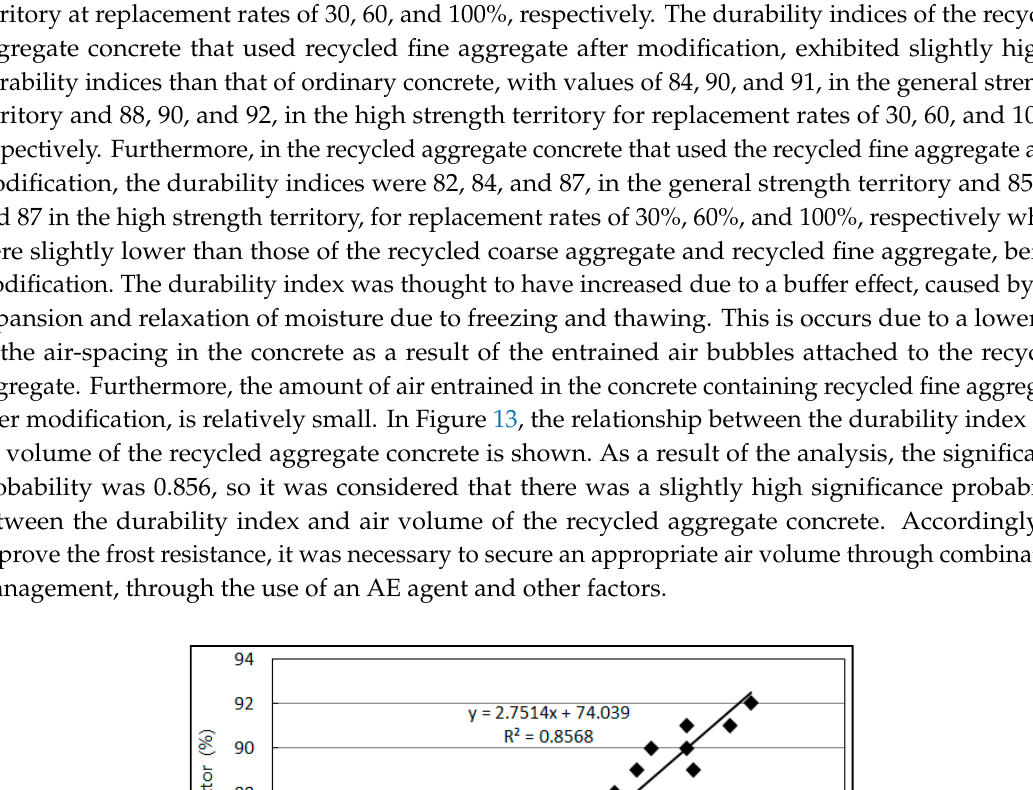
Figure 12. Relative dynamic elastic modulus and number of cycles: ( a ) Recycled coarse aggregate replacement, ( b ) recycled fine aggregate before modification, and ( c ) recycled fine aggregate after modification.